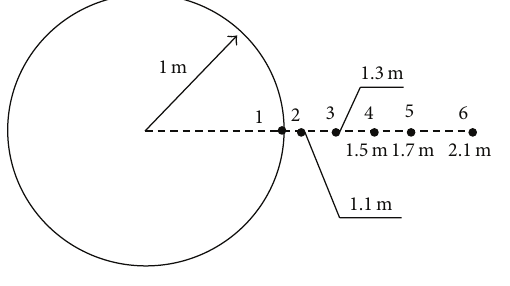
Figure 3: Position of monitored point in circular tunnel.